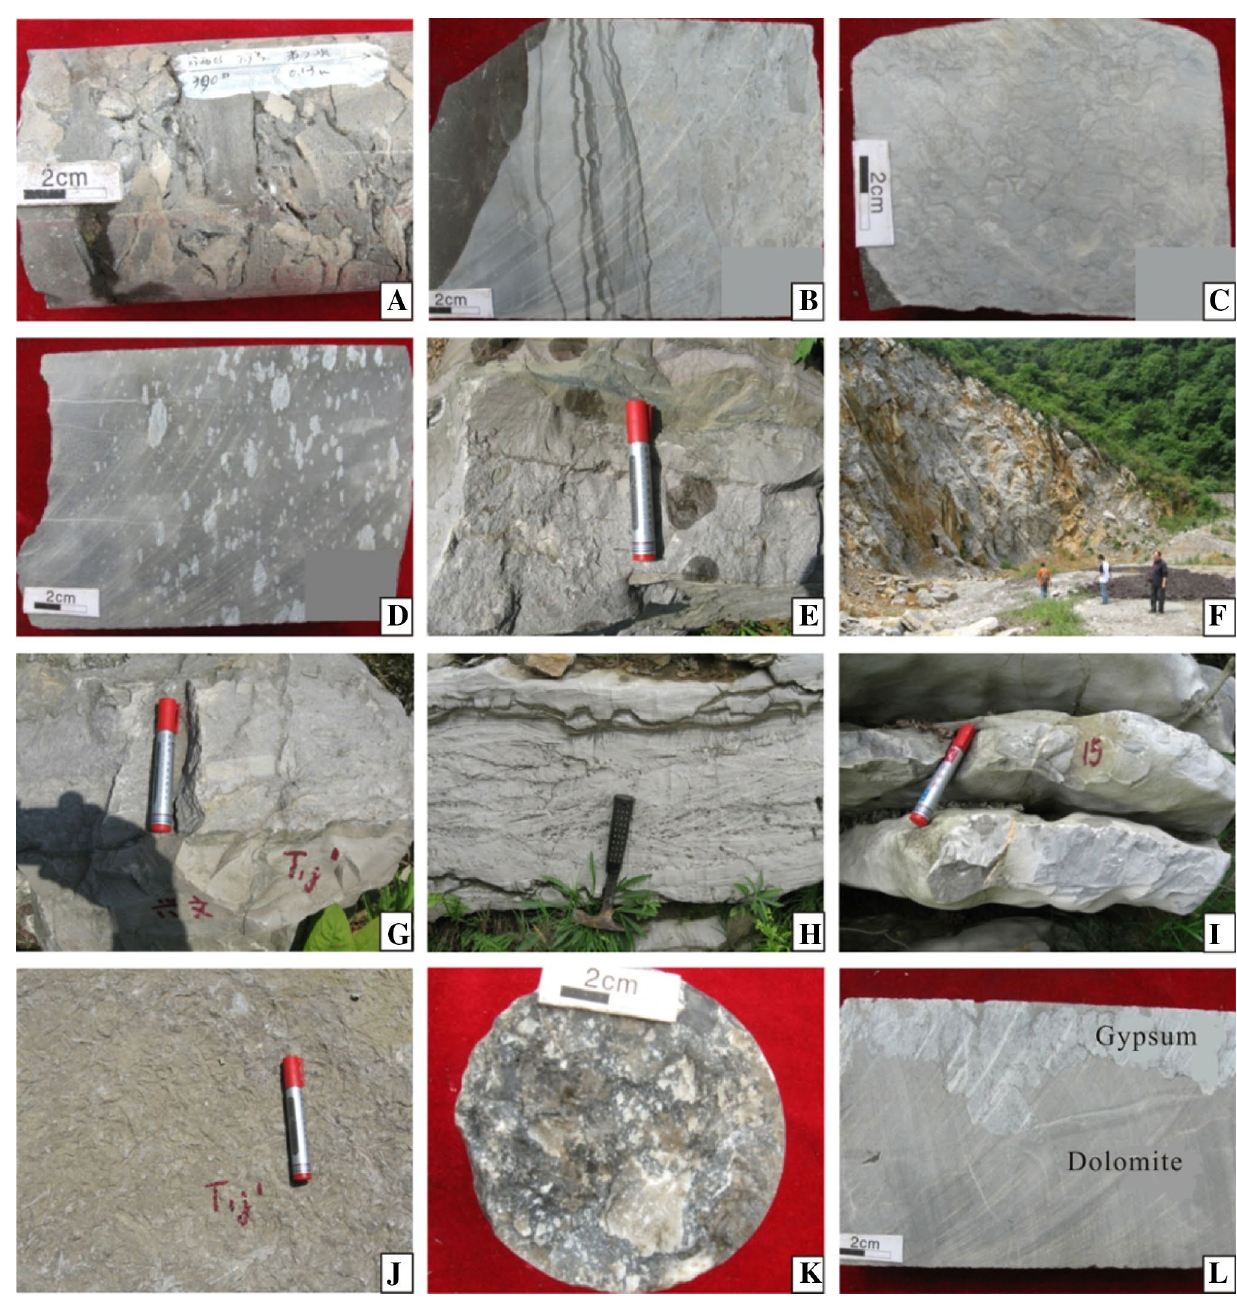
Fig. 2 Photographs of the profiles and cores: a Gypsum breccias, Menxi 8, T1j4; b light gray taupe limestone, Tiexi 1, T1j1; c muddy- silty dolomite, Tiexi1, T1j2; d micritc gypsum dolomite, bird-eye structure, Tiexi 1, T1j2; e bioclastic-bearing limestone, Xingwen- wangchengpo Profile, T1j1; f light gray micritic limestone,